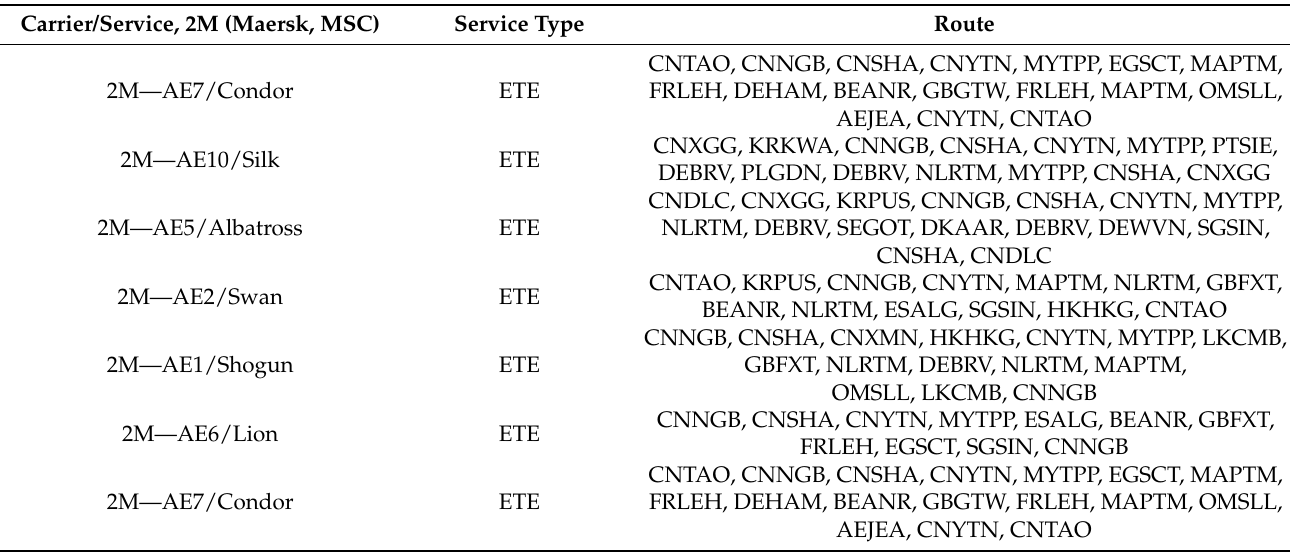
Table 1. Partial route data from Container Forecaster in 2019 of